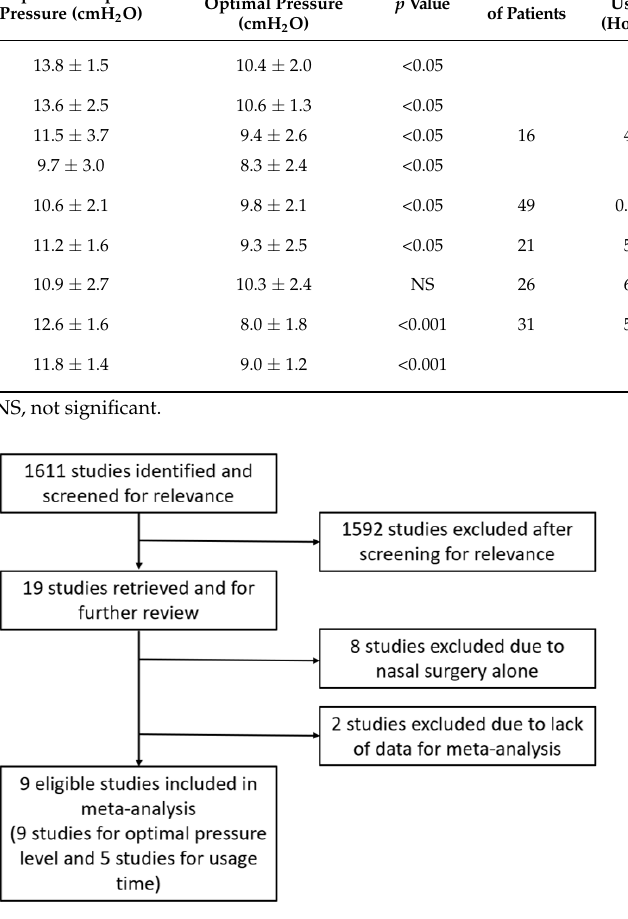
Figure 1. Flow diagram of the literature selection. Table 1. Characteristics of the included studies.